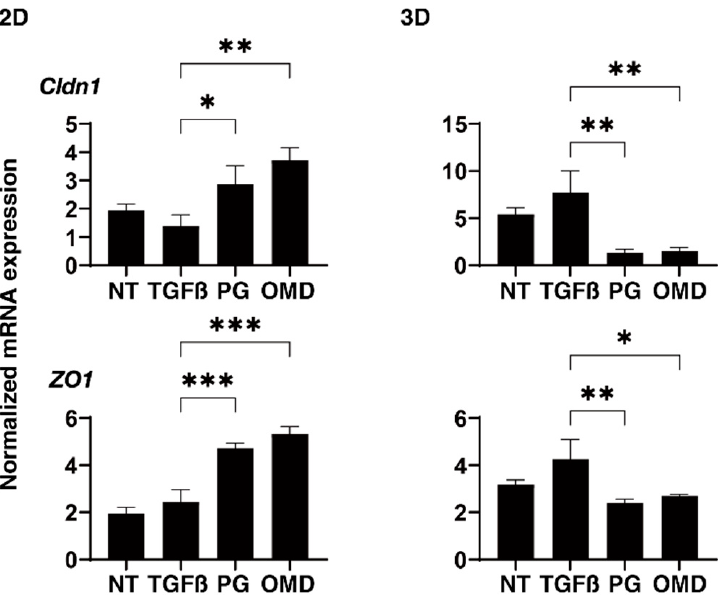
Figure 6. Effects of PGF2 α and the EP2 agonist, omidenepag (OMD), on the mRNA expressions of tight junction related proteins in 2D- and 3D-cultured HTM cells. At Day 6, 2D and 3D cultured HTM cells (NT: non-treated control) and those treated with a 5 ng/mL solution of TGF- β 2 (TGF β ) in the absence and presence of 100 nM PGF2 α (PG) or the EP2 agonist, omidenepag (OMD) were subjected to mRNA expression analysis of mRNA in claudin11 (Cldn11) and ZO1. Analyses were performed in triplicate using fresh preparations ( n = 12–15 3D spheroids each). Data presented are the arithmetic mean ± standard error of the mean (SEM), and statistical differences were determined by ANOVA followed by a Tukey’s multiple comparison test. * p < 0.05, ** p < 0.01, *** p < 0.005. Table 1. Summary of mRNA expressions of ECM proteins, tight junction-related molecules, TIMPS, MMPs, CRGF, and ER stress-related factors.